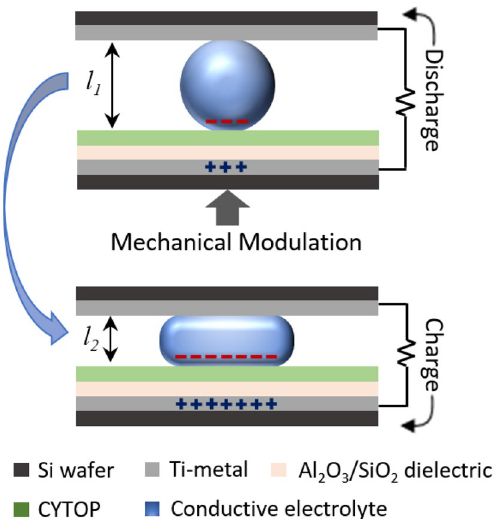
Figure 1. Working principle of REWOD energy harvesting without any applied bias voltage. Maximum mechanical displacement of electrodes during modulation, Δl is given as: Δl = l 1 − l 2